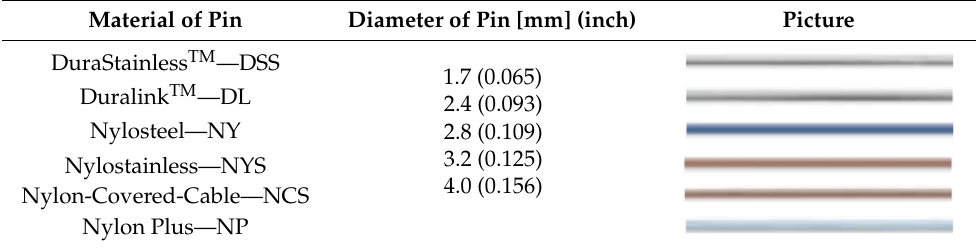
Table 9. Connecting pin types for the wire hook fastening [25]. Material of Pin Diameter of Pin [mm] (inch)